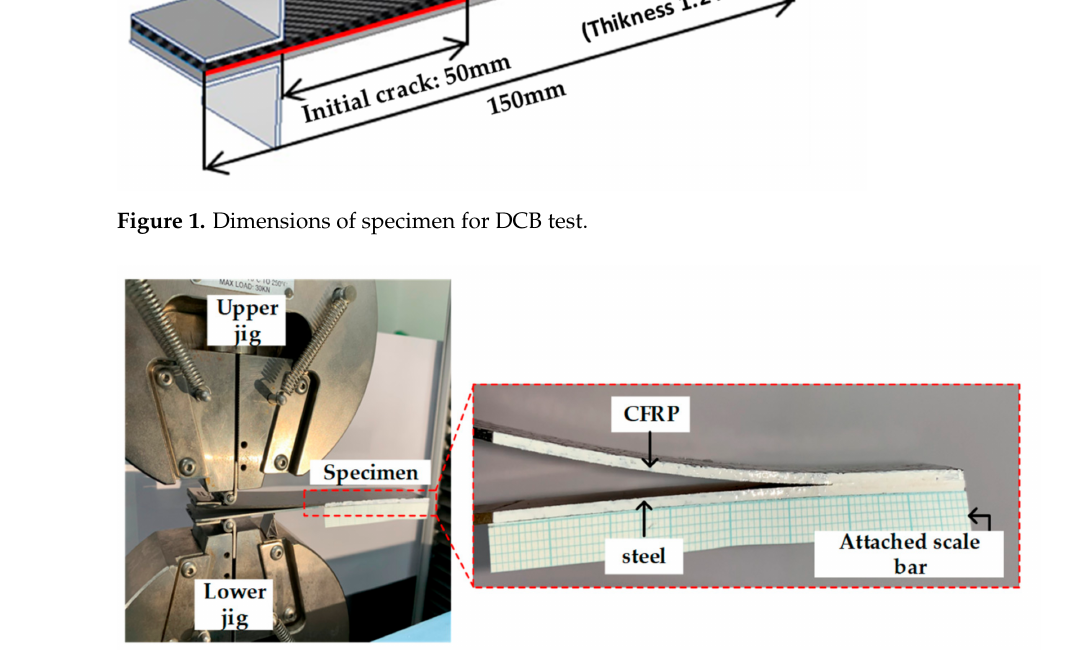
Figure 2. Experimental setup for DCB test.